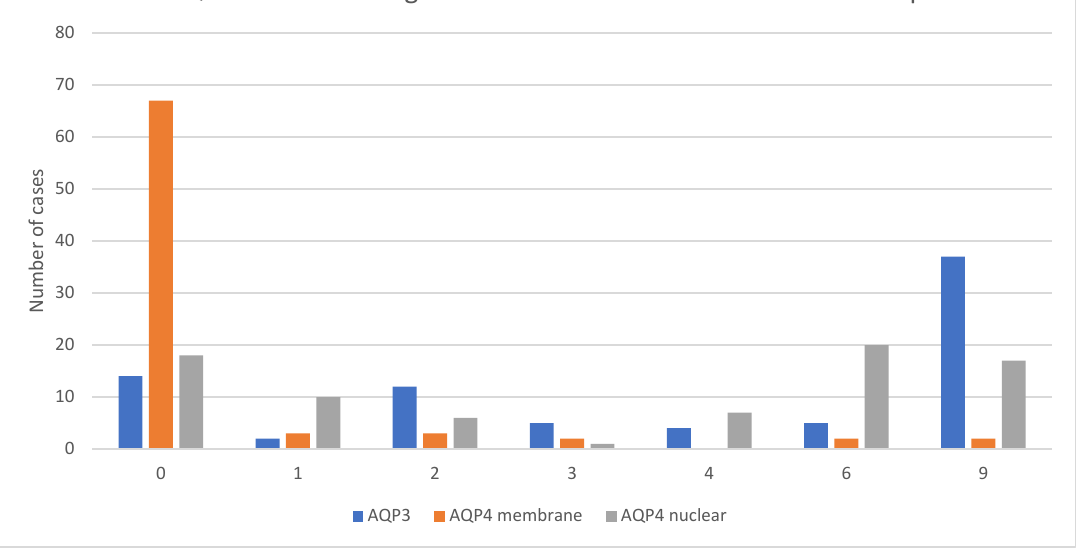
Figure 3. Bar diagram representing the number of lung adenocarcinoma (ADC) samples (Y axis) with low (0–2) or high (3–9) immunostaining scores (X axis) of aquaporin 3 (AQP3; blue bars), aquaporin 4 (AQP4) expressed in the cytoplasmic membrane (orange bars) or AQP4 expressed in the nucleus (grey bars).